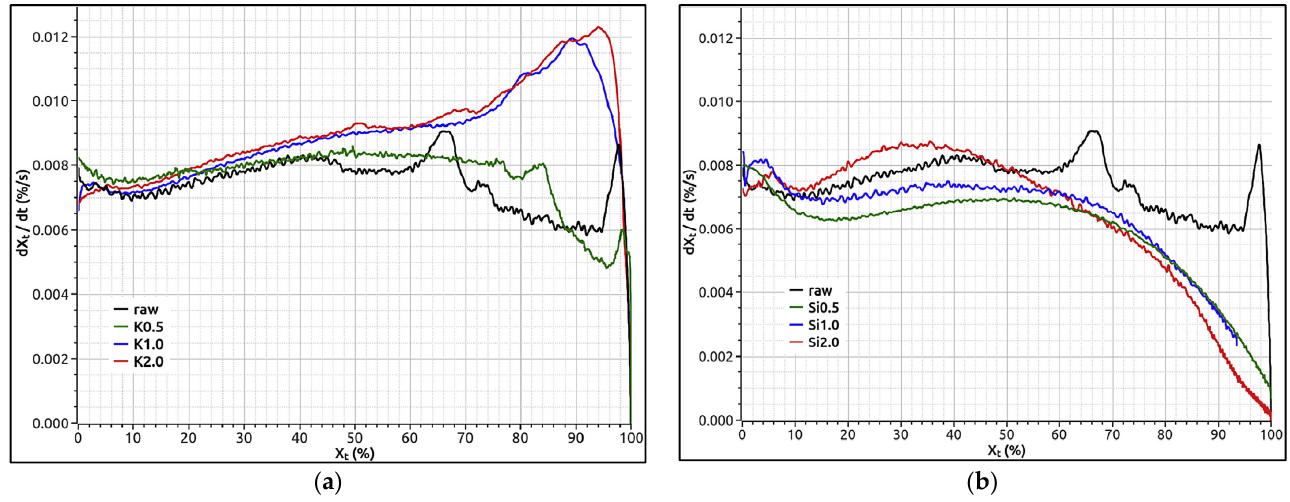
Figure 10. CO 2 gasification rates of beechwood char samples impregnated with ( a ) K (0.5 wt. %, 1 wt. %, and 2 wt. %), and ( b ) Si (0.5 wt. %, 1 wt. %, and 2 wt. %) [159]. Table 5. Experimental studies investigating the effects of externally added inorganic content on gasification.